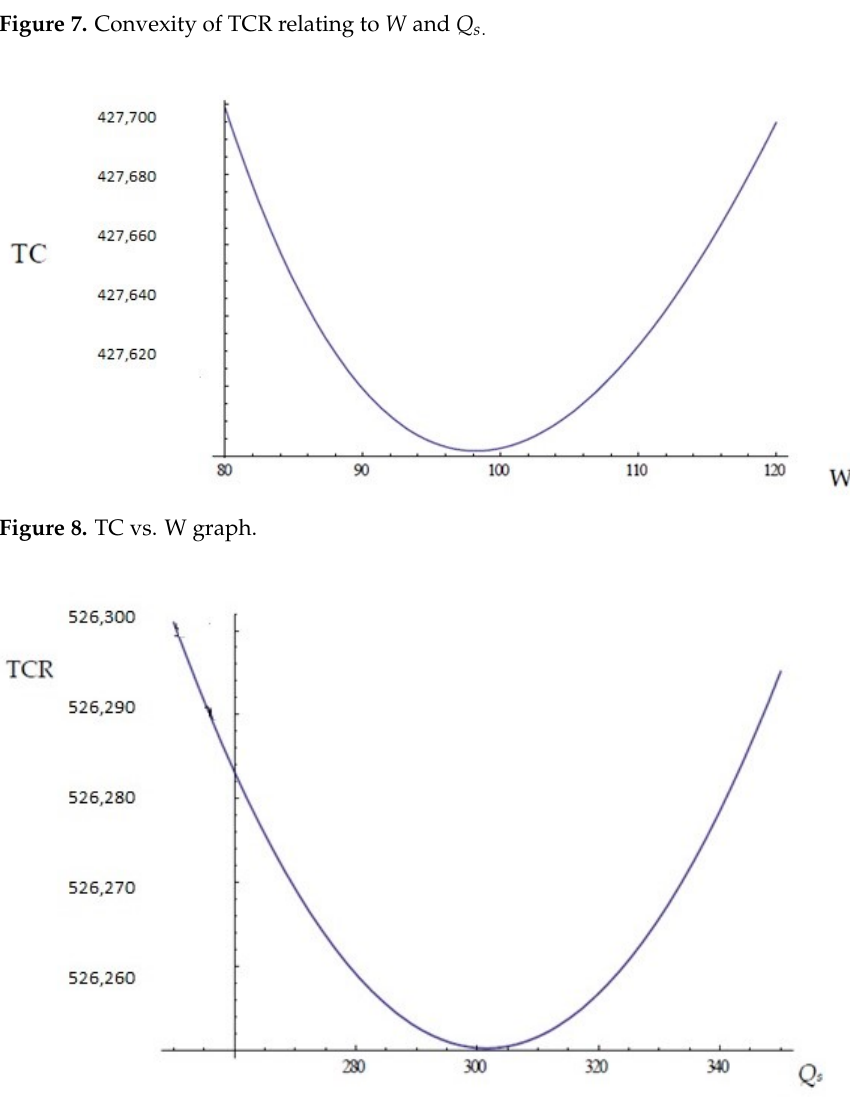
Figure 9. TCR vs. Q s graph.